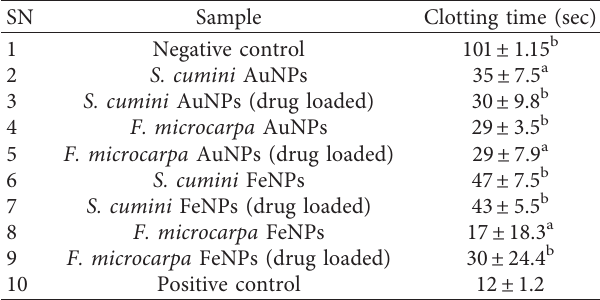
Figure 6: Percentage edema inhibition of different nanoparticles by carrageenan-induced rat paw edema test (S. cumini AuNPs: Syzygium cumini gold nanoparticles, S. cumini FeNPs: Syzygium cumini iron nanoparticles, F. microcarpa AuNPs: Ficus microcarpa gold nano- particles, F. microcarpa FeNPs: Ficus microcarpa iron nanoparticles). Data represent the mean with statistical significance a: p < 0 . 001, b: p < 0 . 01, c: p < 0 . 05, ns: nonsignificance. Table 2: Effect of nanoparticles on blood clotting